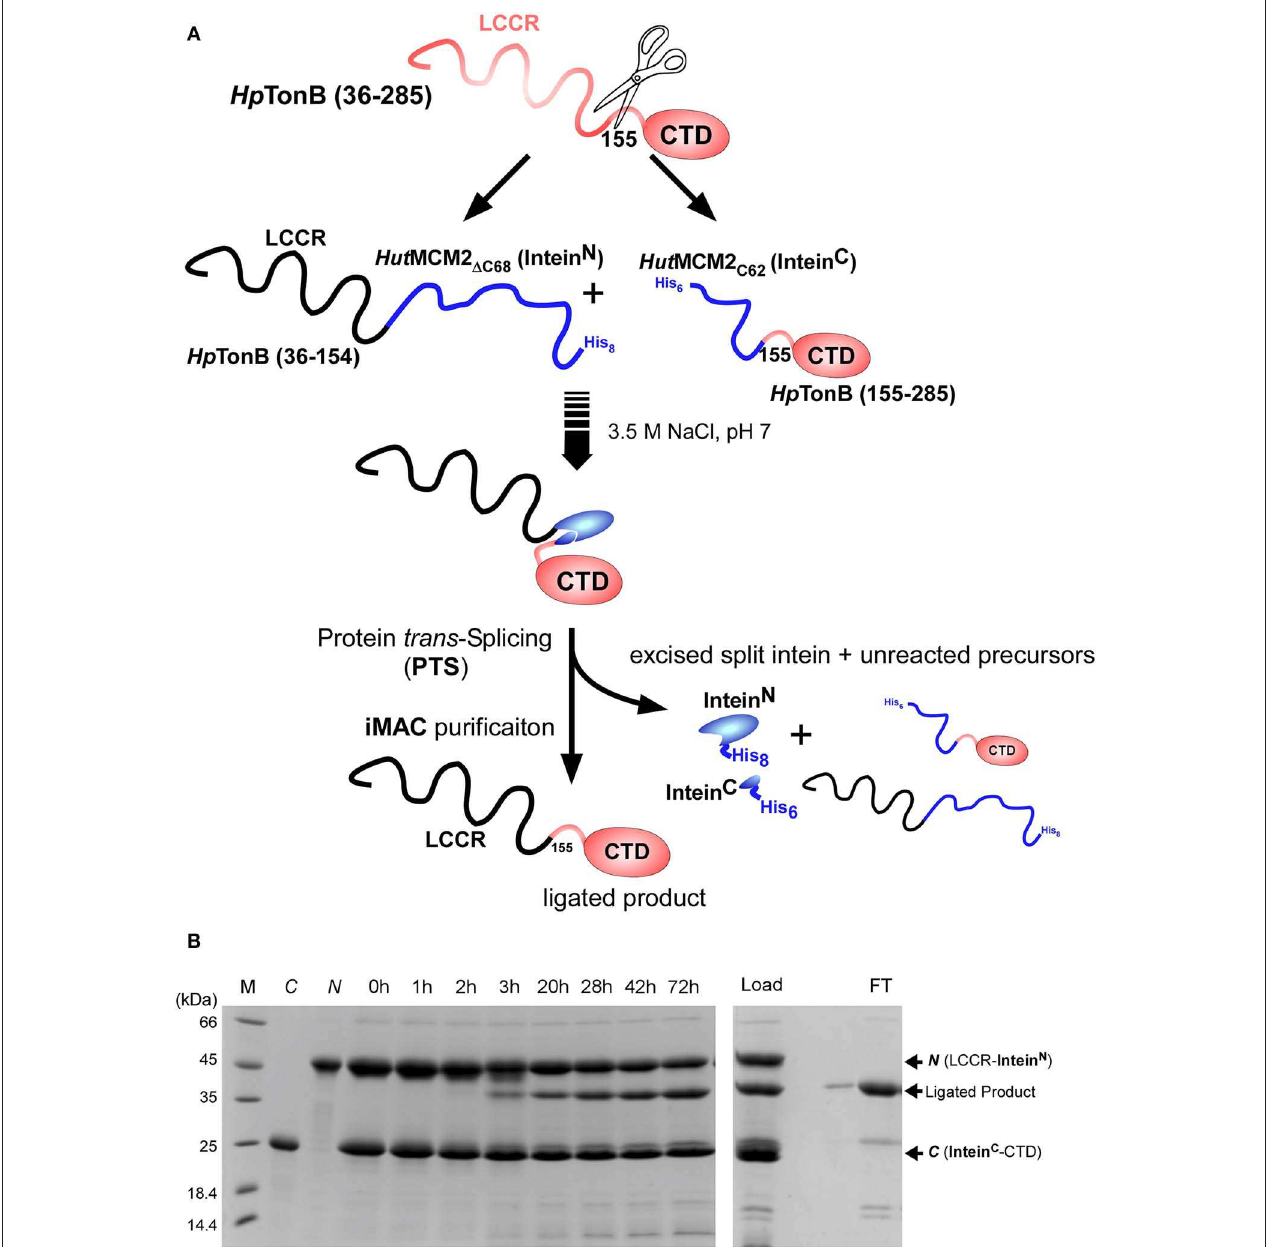
FIGURE 3 | Segmental labeling of Hp TonB (36–285). (A) Schematic diagram showing the scheme for segmental labeling either the C-terminal or N-terminal domain of Hp TonB (36–285) by the split Hut MCM2 intein. (B) In-vitro ligation of segmentally labeled Hp TonB (36–285) by PTS using the salt-inducible Hut MCM2 intein with Lys at the − 1 position. SDS-PAGE analysis shows the time course of the protein ligation reaction. M, C , and N stand for molecular weight marker, C-terminal and N-terminal precursors before mixing, respectively. Lanes 0–72h indicate the time (hours) of the ligation reaction after mixing the N- and C-terminal precursors in 3.5M NaCl. The right panel shows the SDS-PAGE analysis of the IMAC purification step, which removes His-tagged precursors and excised intein fragments simultaneously. “Load” and “FT” indicate the sample loaded on the IMAC column and the flow-through fraction, respectively. N and C indicate the N- and C-terminal precursors, respectively.